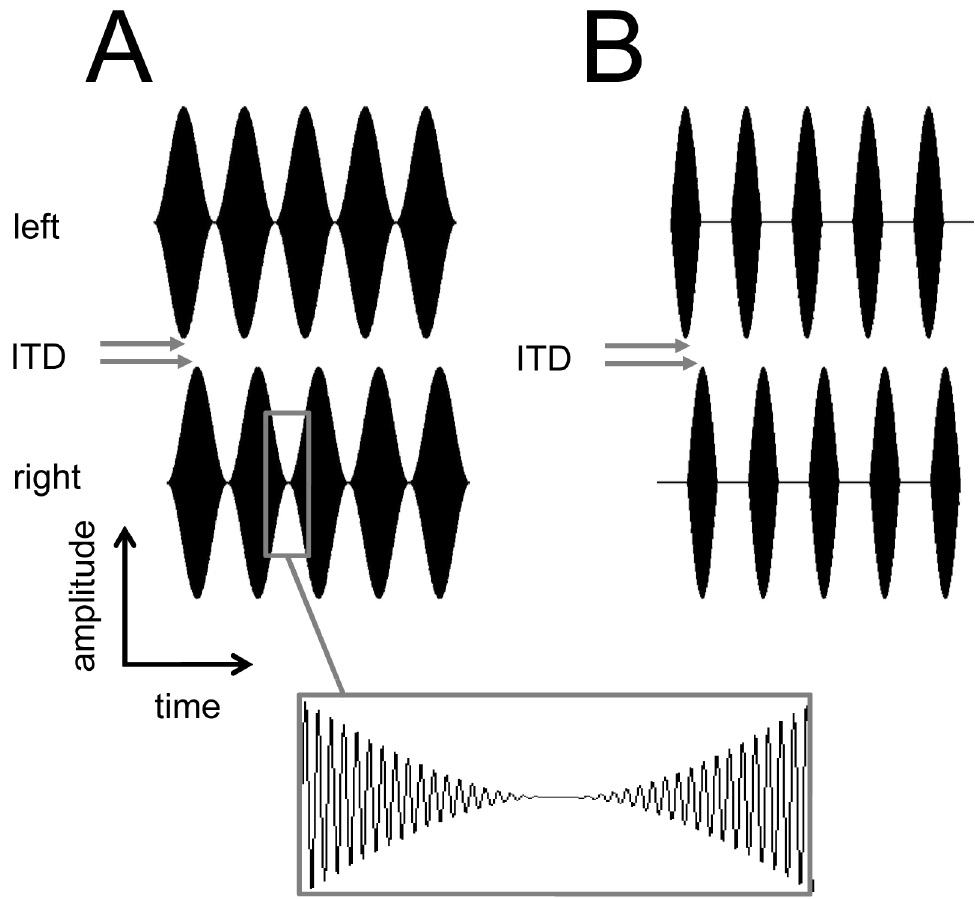
Figure 1. Acoustic stimuli presented to normal-hearing animals. Time waveforms illustrating the acoustic stimuli that were presented, including SAM (A) and HWR tones (B). An interaural time delay (ITD) was created by delaying the envelope in one channel and advancing it in the other by an equal amount. The box shows a segment of the stimulus envelope and fine structure in more detail.